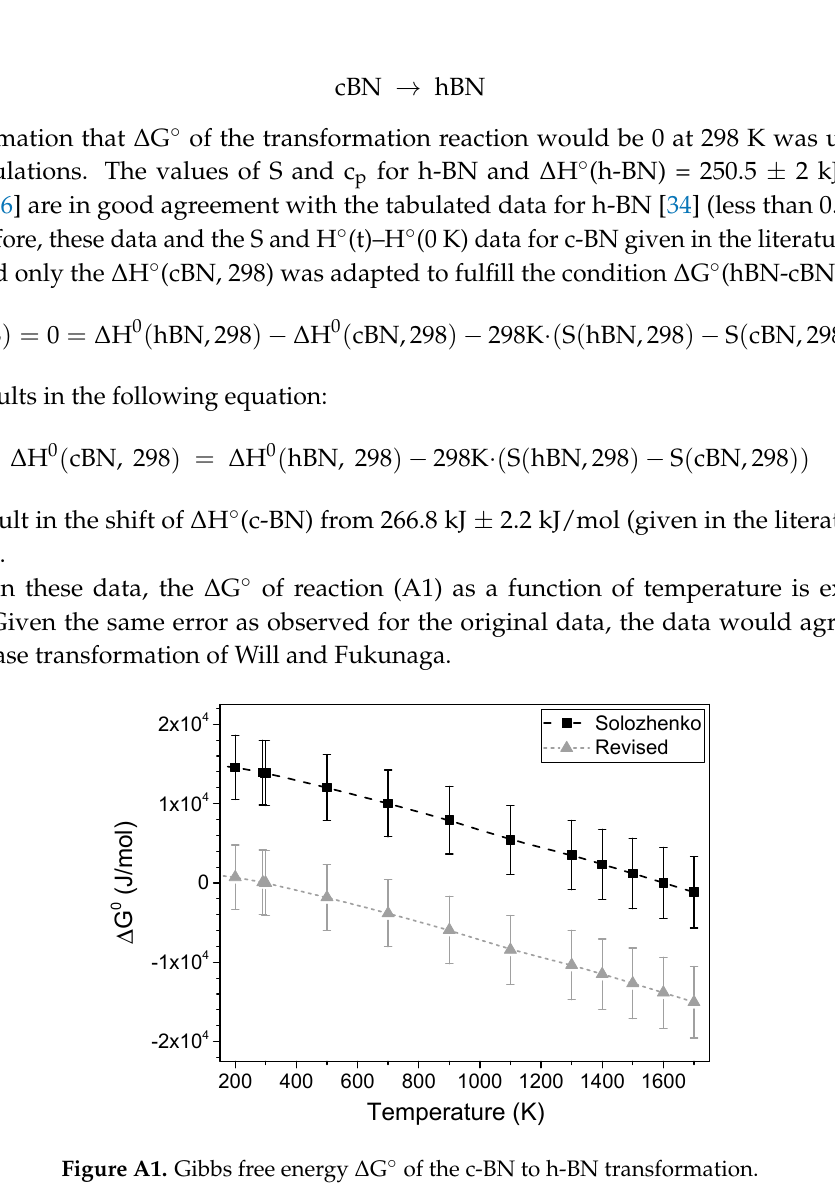
Figure A1. Gibbs free energy Δ G° of the c-BN to h-BN transformation.